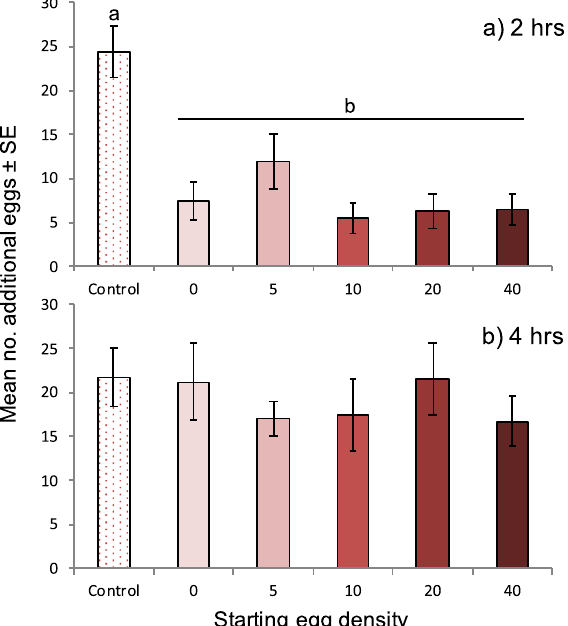
Figure 2. D. suzukii preference for unmarked substrates is modulated by host marking behavior during the assay. Mean ± SE number of eggs oviposited per dish on a less preferred raspberry puree-agar substrate in multi-choice assays. All dishes, except Control dishes, were exposed to adult D. suzukii for 2 h before the assay, and the starting egg density (per dish) was achieved by removing or adding eggs to dishes before the assay began. ‘Control’ is an unmarked, unoccupied dish. ( a ) 6-way comparison with dishes exposed for 2 h, ( b ) 6-way comparison with dishes exposed for 4 h. Values sharing the same letter are not significantly different (ANOVA, alpha =